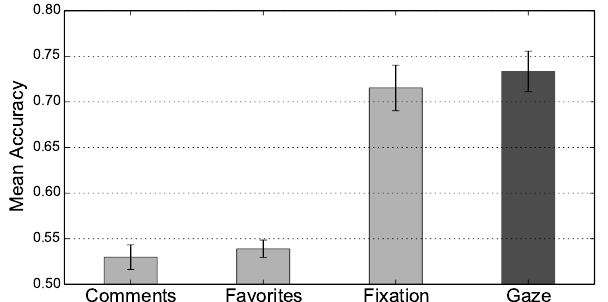
Figure 2 . Comparison with baseline methods. The graphs show the mean accuracies from the 14 participants and the error bars indicate the standard errors. The first two graphs show the classification results using the objective metadata, which was the number of comments and favorites on the Flickr website. The third graph shows the accuracy of the simple classification using only the sum of the fixation du- ration, and the last graph corresponds to the proposed gaze- based